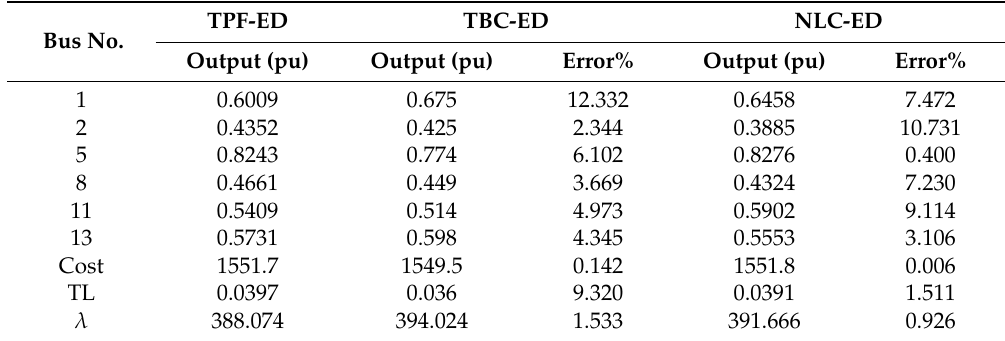
Table 11. ED simulation results compared with traditional ED and new loss coefficients of the IEEE 30-bus system under the conforming system demand decreased by 20% condition.